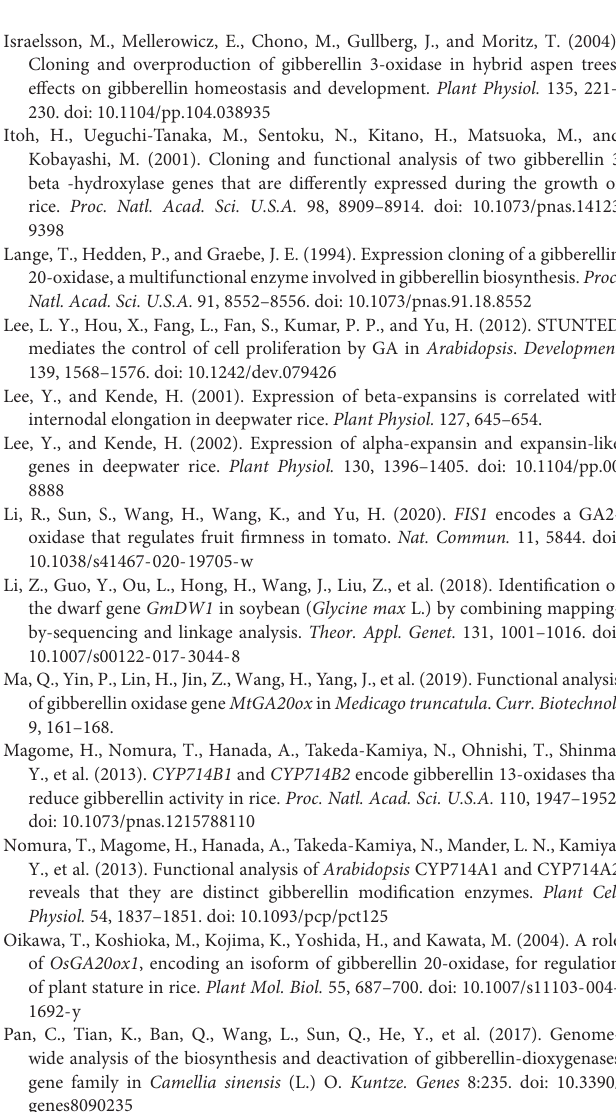
Supplementary Figure 1 | Amino acid sequence alignment of MSD1 and its close homologs in Arabidopsis and M. truncatula . Supplementary Figure 2 | Identification of the mtga20ox7 mutant. Supplementary Figure 3 | Identification of the mtga20ox8 mutant. Supplementary Table 1 | Primers used in this study. Supplementary Table 2 | Accession numbers used in this